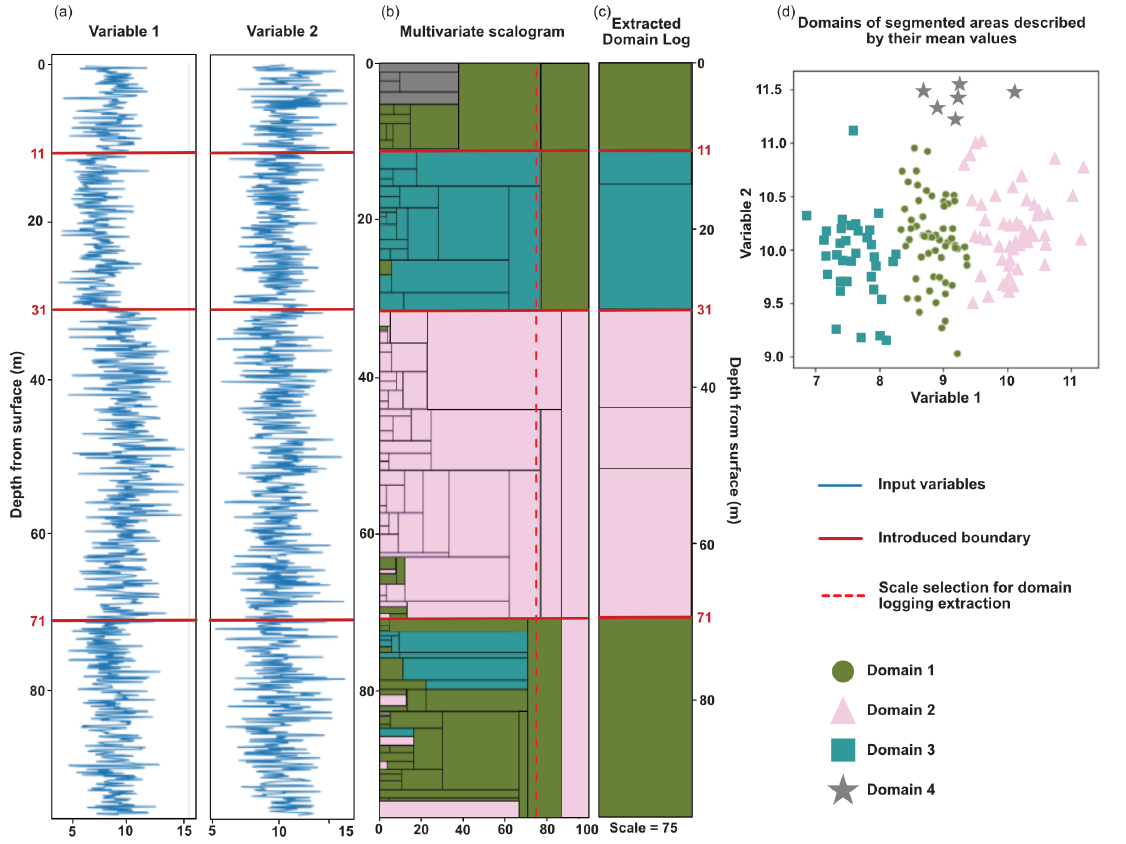
Figure 5. Results of the synthetic dataset. ( a ) The two synthetic variables used as input data. ( b ) mul- tivariate scalogram and domains based on unsupervised domaining. ( c ) Domain and segmentation data extracted at a scale of 75 shown as a logging file. ( d ) Scatterplot of compositional data for each segmented area described by the mean of their input